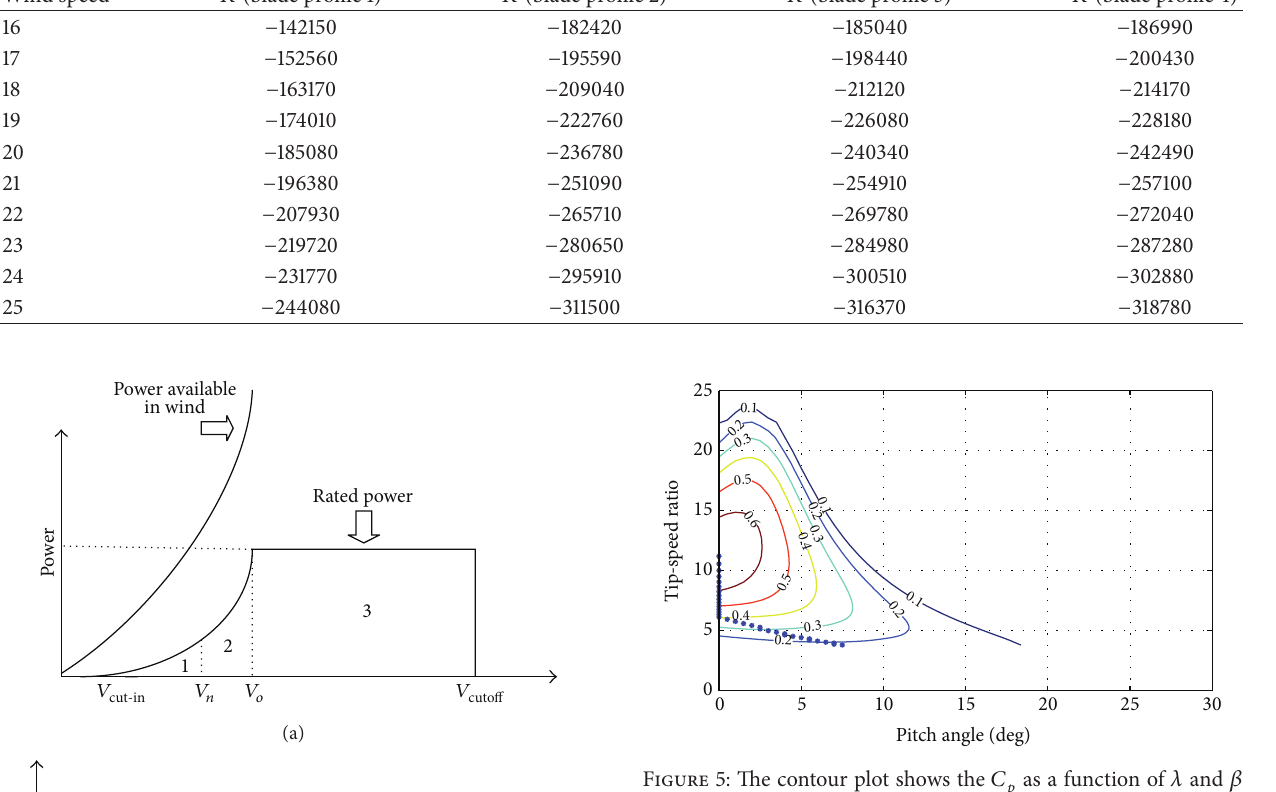
Table 2: Different 𝐾 values calculated through the different blade profiles. All the 𝐾 values are similar to each other. Wind speed